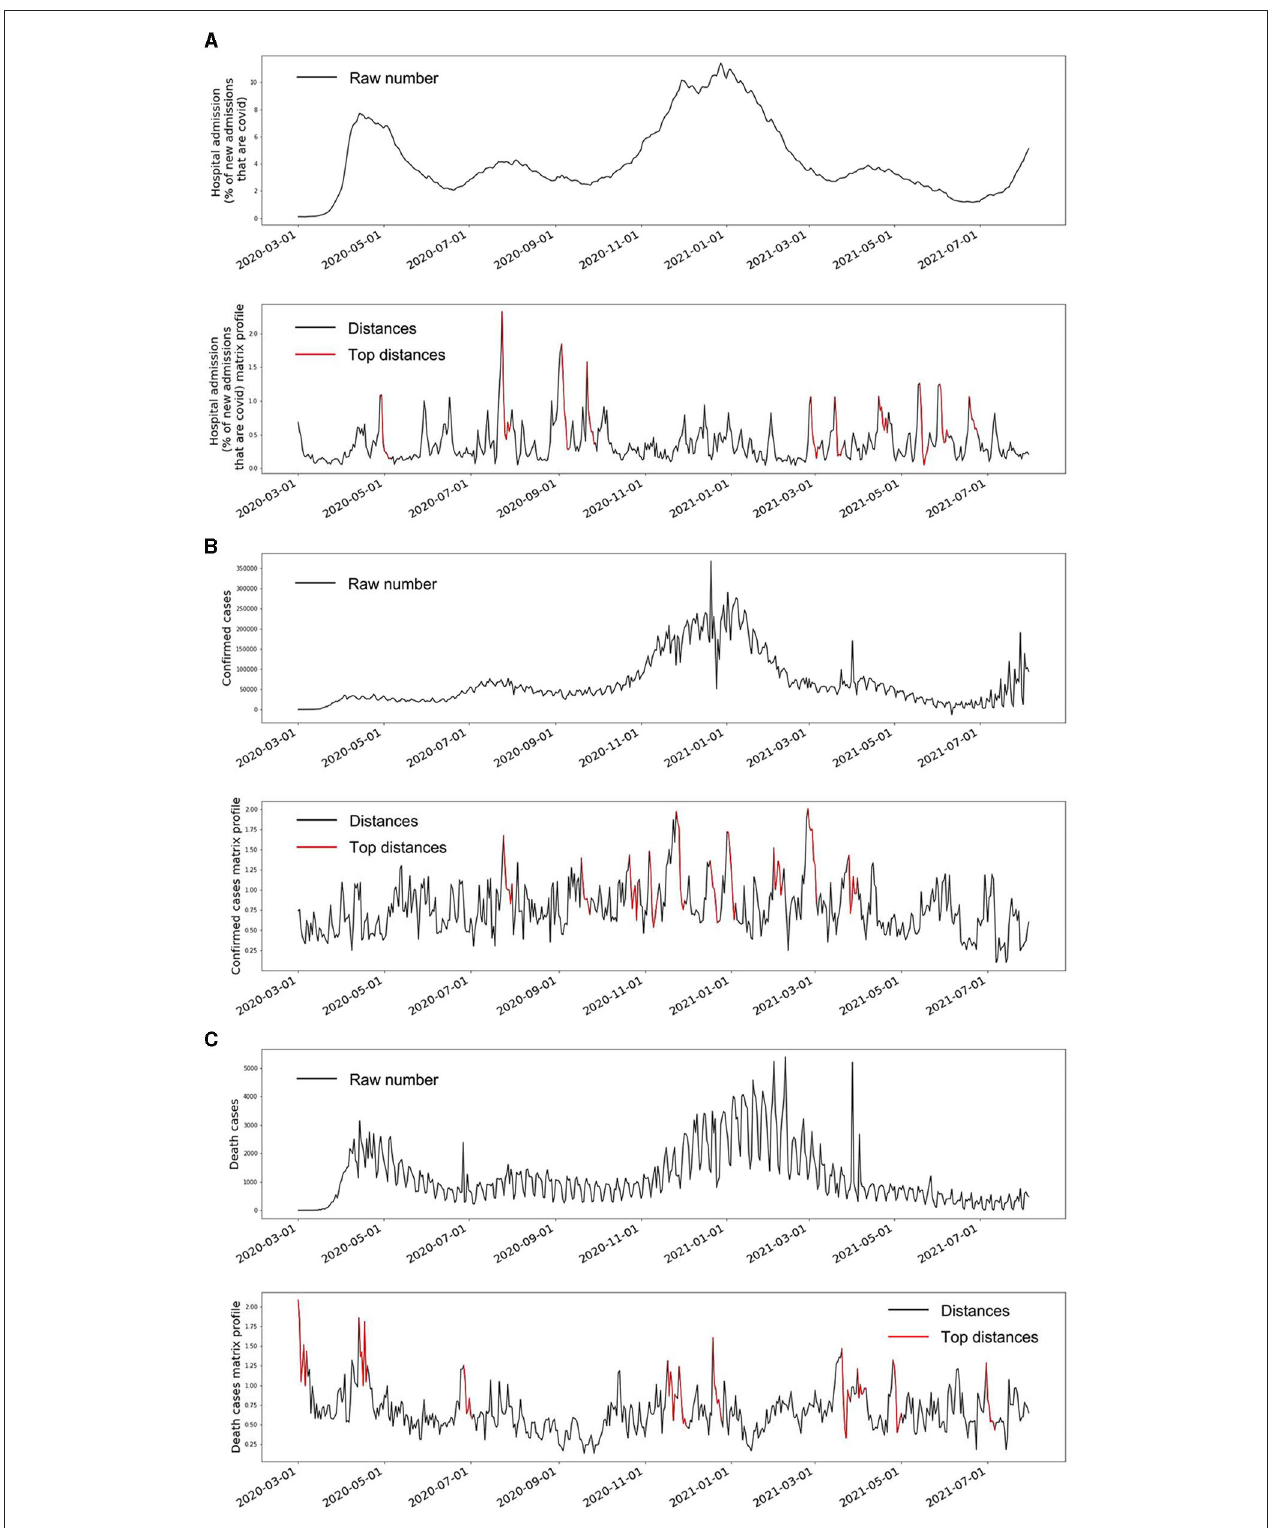
FIGURE 3 | The raw time series and the matrix profile of the three indicators. (A) is the time series of COVID-19 hospital admissions and its matrix profile. (B) is the time series of the daily confirmed COVID-19 cases and its matrix profile. (C) is the time series of the daily death cases caused by COVID-19 and its matrix profile. The red segments in the matrix profile plots indicate the corresponding weeks that have large Euclidean distances to their nearest neighbor compared to all the other weeks, which also means these weeks marked as red are the top anomalies within the whole time series.